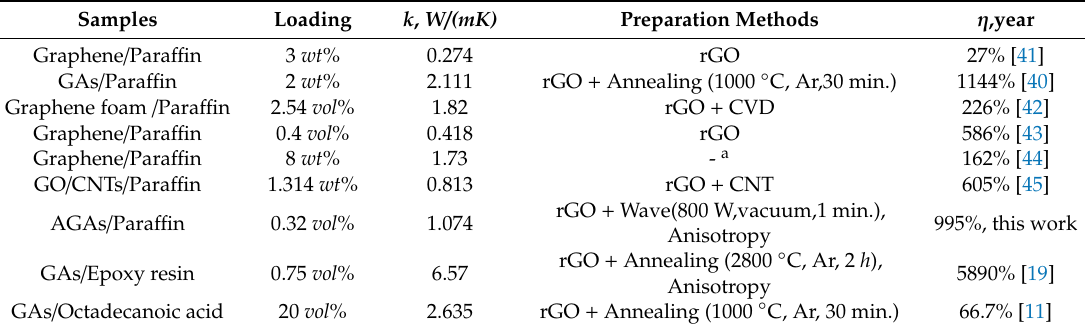
Figure 11. ( a ), ( c ), ( d ), ( e ) and ( f ) are the curves of temperature difference with time during the Figure 11. ( a , c – f )are the curves of temperature di ff erence with time during the thermal conductivity thermal conductivity test of AGA/paraffin composite materials, and ( b ) is the thermal conductivity test of AGA / para ffi n composite materials, and ( b ) is the thermal conductivity (axial). (axial). Table 5. Comparison of graphene-enhanced heat conduction reported in the literature with that of this